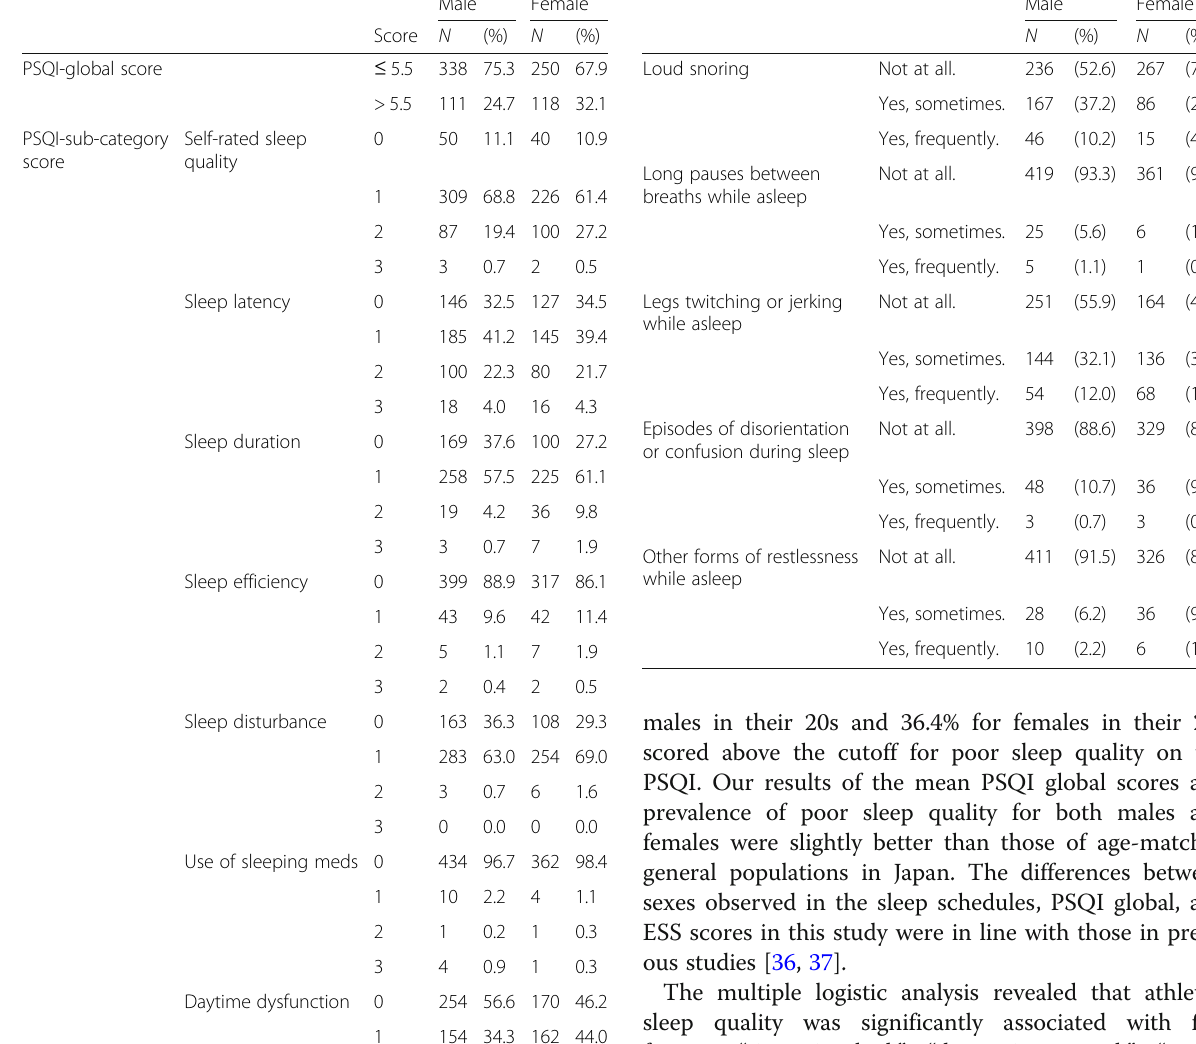
Table 4 The frequency and distribution of responses to clinical Male